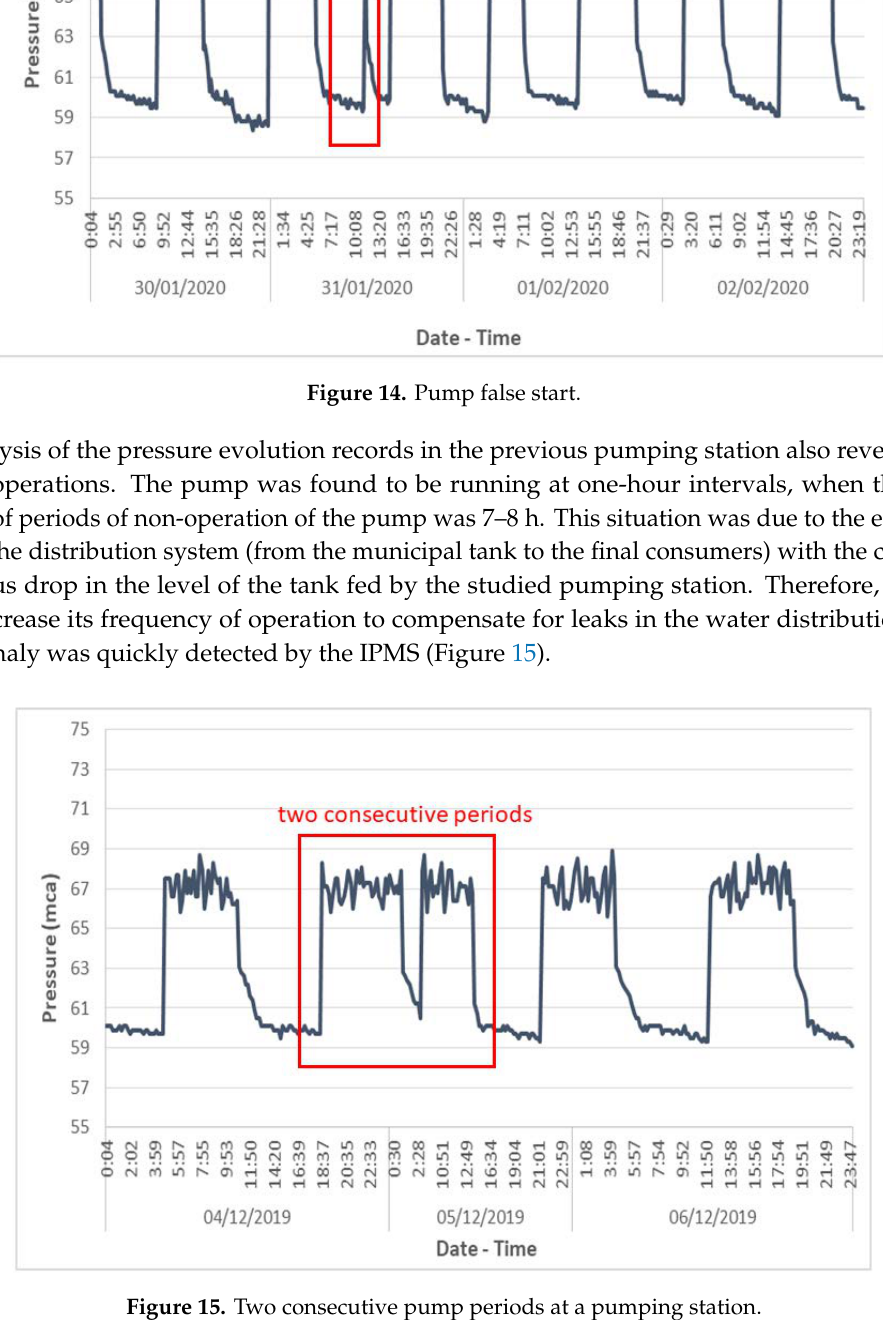
Figure 15. Two consecutive pump periods at a pumping station.